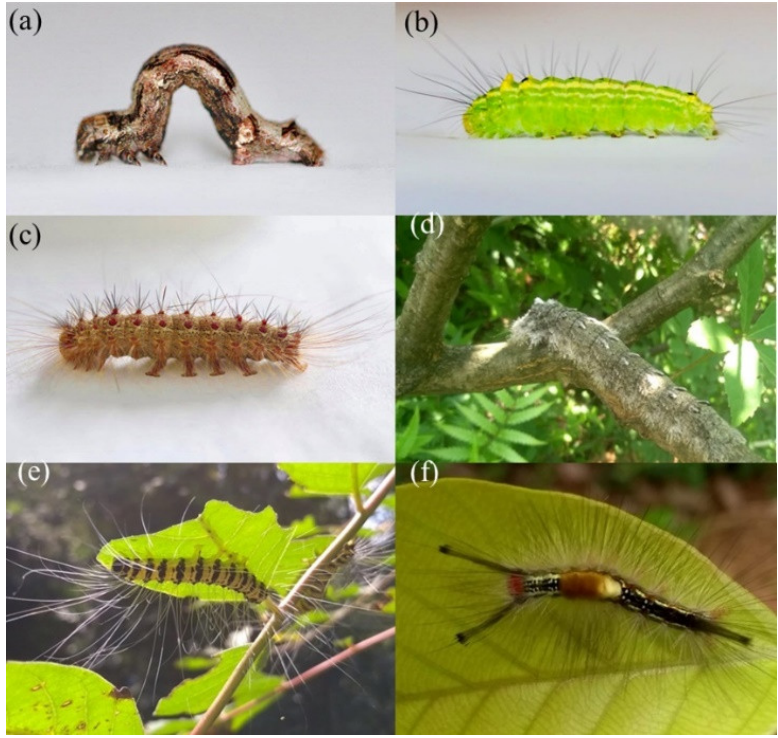
Figure 1. Hair coverage and coloration categories employed in this study, presented by example species encountered in BEF-China: ( a ) 0, ( b ) <25%, ( c , e ) <50%, and ( d , f ) >50% hair coverage. Pictures